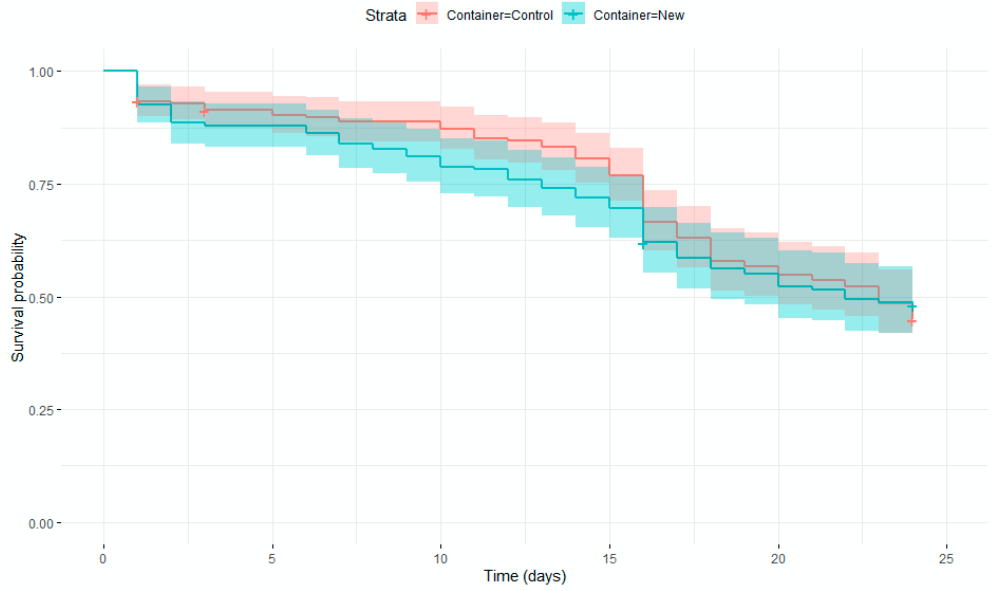
Figure 3. Kaplan–Meier plot to illustrate the survival of male mosquitoes in two different containers. Shaded areas show 95% confidence intervals. Crosses show censored individuals.